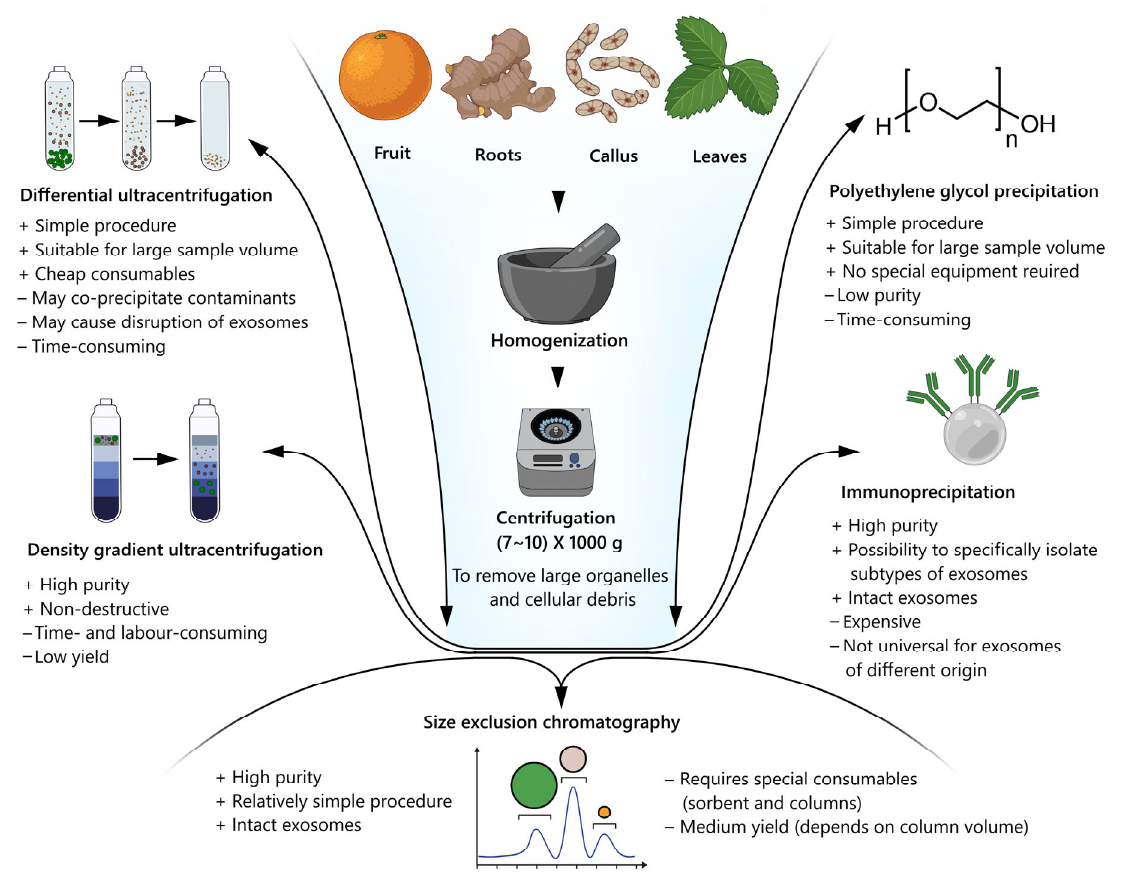
Figure 2. Schematic flow diagram of the isolation and purification of plant nanovesicles. Density gradient ultracentrifugation is based on the separation of nanovesicles de ‐ pending on their size, mass, and density in a centrifuge tube with a pre-designed medium with a gradually decreasing gradient. The sample is subjected to a long cycle of ultracentrifugation, whereby the solutes of the sample, including the nanovesicles, move as separate zones through the medium with a density gradient to the bottom, each with its own specific sedimentation rate [71]. The samples of nanovesicles isolated by this